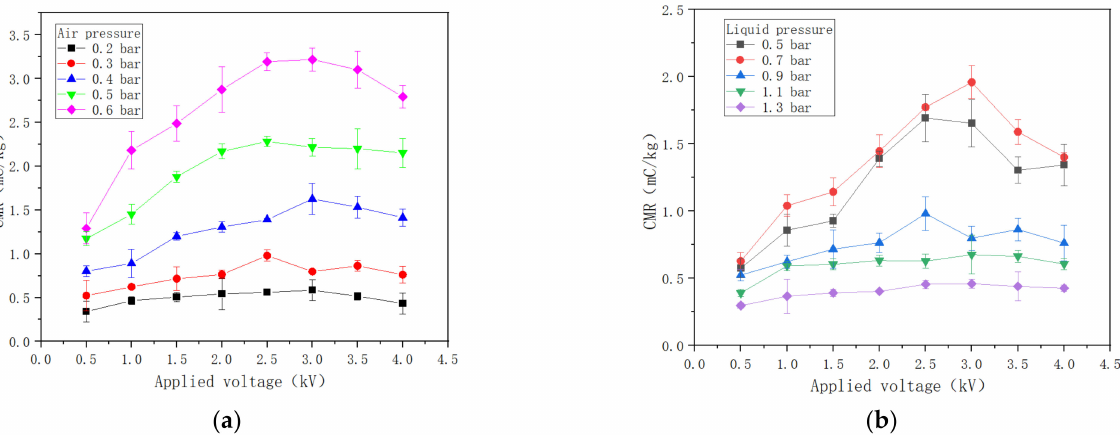
Figure 9. CMR variation with the applied voltage. ( a ) Liquid pressure of 0.9 bar, ( b ) Air pressure of 0.3